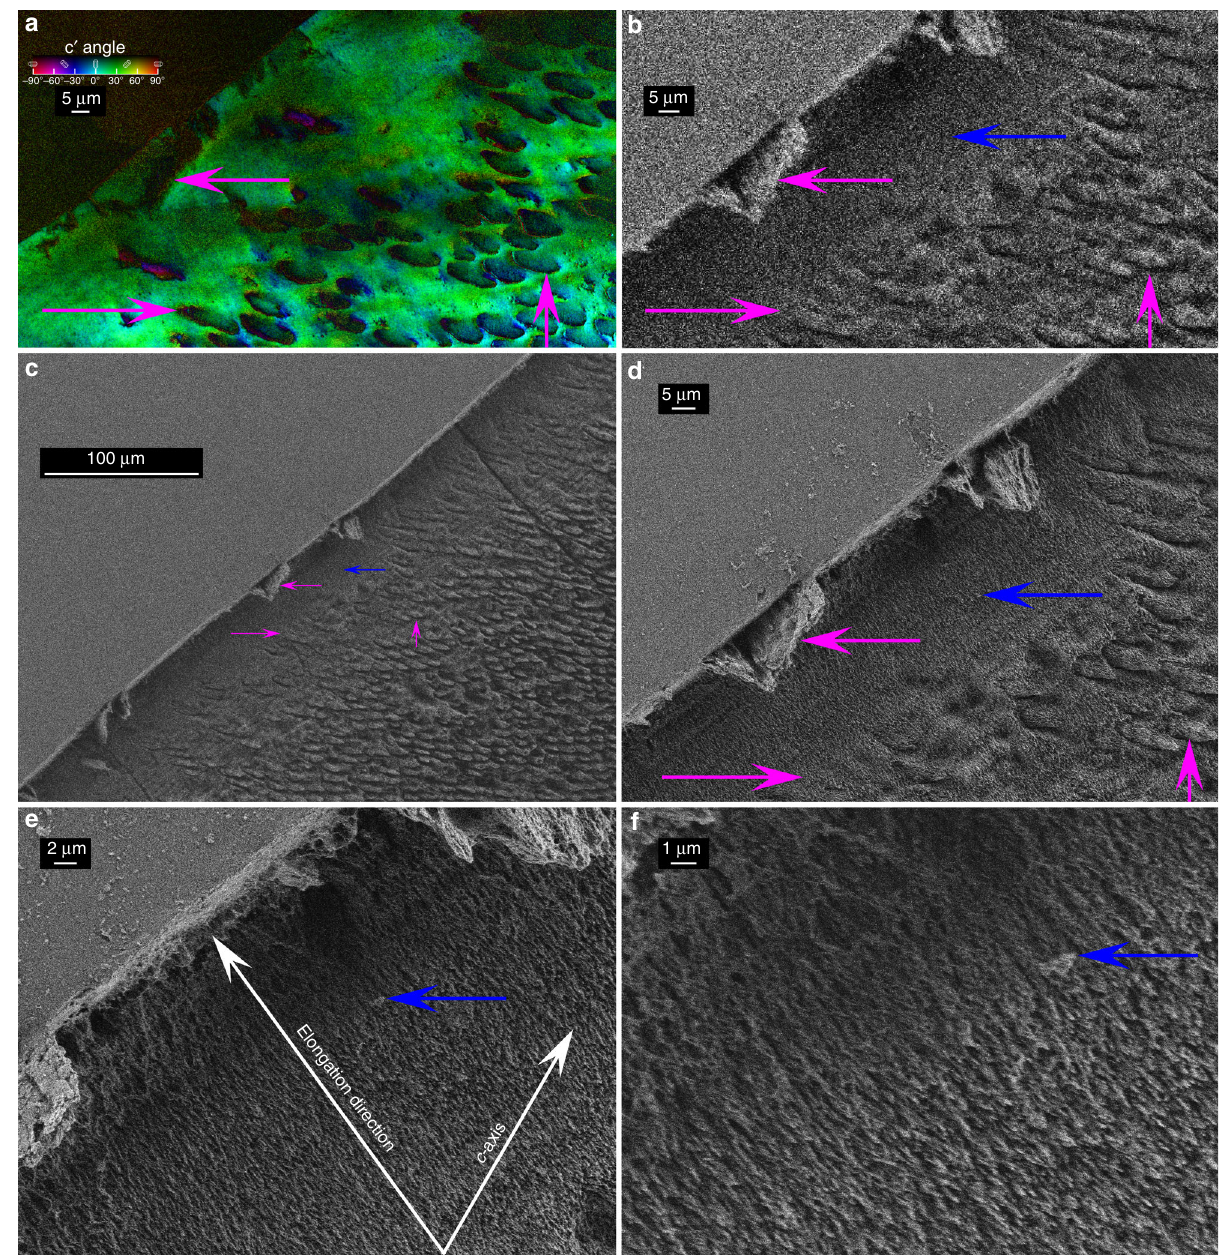
Fig. 7 Aprismatic enamel at the tooth cusp surface. Notice that the aprismatic enamel is indistinguishable from the interrod, it just does not have any rods (previously termed prisms, whence the name of this aprismatic layer). See Supplementary Fig. 3 for the precise position of this region in the tooth. a PIC map of aprismatic enamel, showing that nearly all crystals are green, thus their c -axis is oriented at + 30°. b – f SEM images of the same region after etching. b SEM image at precisely the same magni fi cation as the PIC map in a , with magenta arrows indicating a hole in the tooth surface, in fi ltrated with epoxy, which resisted etching, and two rods. Arrows in a point to the same features before etching. c SEM image of the same region at lower magni fi cation. The arrows were scaled down with the image, and indicate precisely the same features. d – f Increasingly magni fi ed images of etched aprismatic enamel. The blue arrow in panels b – f indicate a feature visible in all SEM images and well resolved in d – f . Panels e and f clearly show that all crystals are aligned parallel to one another and perpendicular to the tooth surface. Panel e shows this as the elongation direction , which is − 36° from the vertical. Their green color in b indicates a c -axis orientation of + 30° from the vertical (also shown in e ), thus the c -axes are 66° apart from the elongation direction, or 24° apart from the tooth surface. Thus, the crystalline c -axes are approximately parallel — not perpendicular — to the tooth surface. Supplementary Fig. 12 shows more PIC maps of the aprismatic layer in another tooth, con fi rming that crystalline c -axes are oriented randomly with respect to the tooth